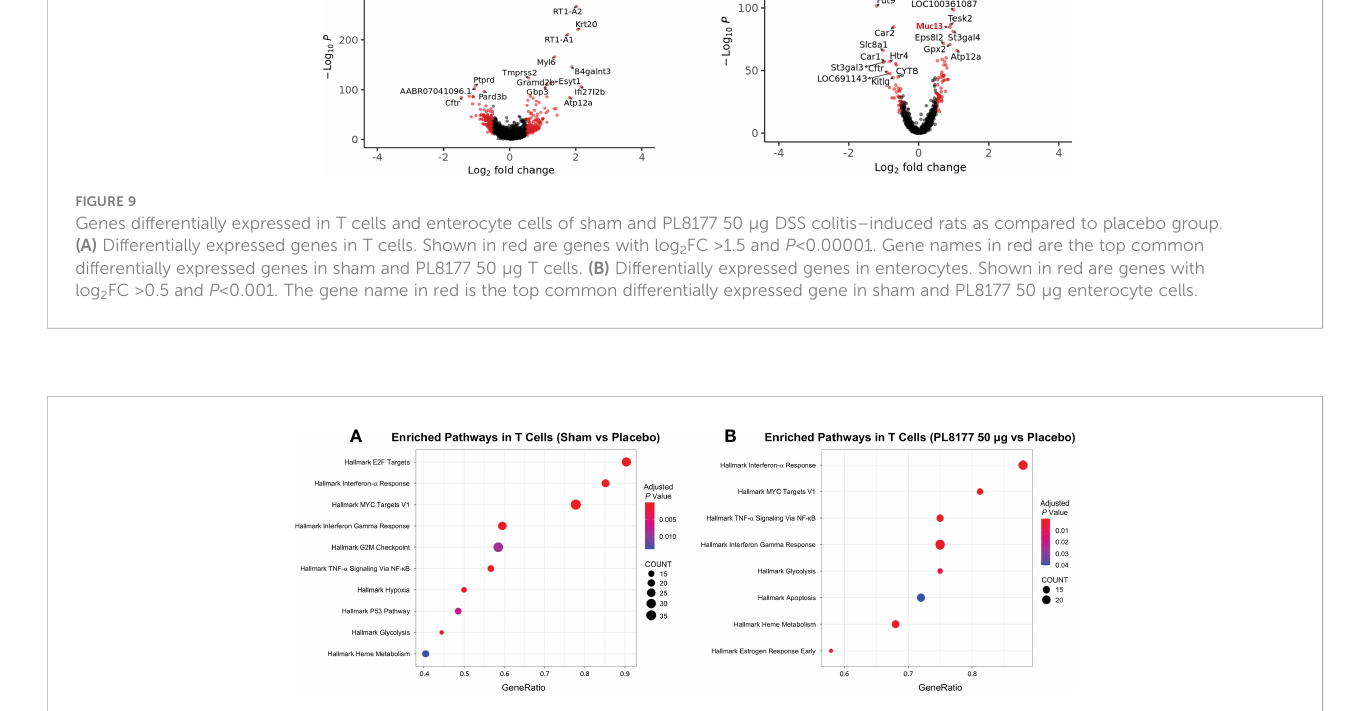
FIGURE 10 Enrichment analysis for differentially expressed T cell cluster genes. Dot plot shows the top 10 signi fi cant pathways enriched in T cells of sham (A) and PL8177 50 µg (B) DSS colitis – induced rats. Differentially expressed genes in sham and PL8177 50 µg as compared to placebo were used for enrichment analysis. Dot size indicates the gene ratio (enriched genes/total number of genes). Dot color indicates the adjusted P value for enrichment analysis. Count indicates number of enriched genes in each pathway. DSS, dextran sulfate sodium; NF- k B, nuclear factor kappa B; TNF- a , tumor necrosis factor